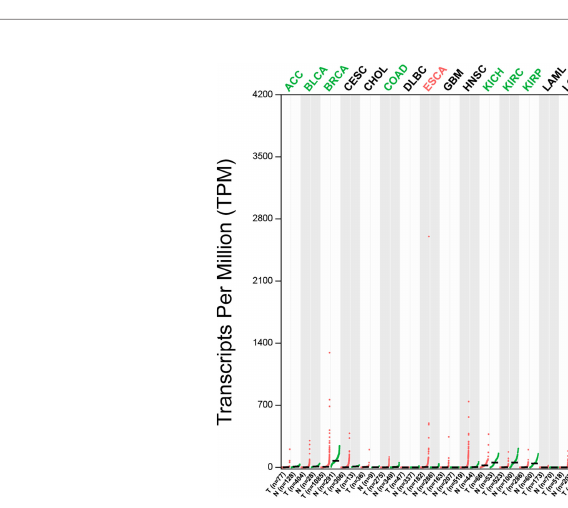
FIGURE 1 | The expression pro fi le of GPC3 across tumor samples and paired normal tissues (Dot plot). Each dot represents expression of samples. T, tumor samples; N, normal tissues; ACC, adrenocortical carcinoma; BLCA, bladder urothelial carcinoma; BRCA, breast invasive carcinoma; CESC, cervical squamous cell carcinoma & endocervical adeno; CHOL, cholangiocarcinoma; COAD, colon adenocarcinoma; DLBC, lymphoid neoplasm diffuse large B-cell lymphoma; ESCA, esophageal carcinoma, glioblastoma multiforme; HNSC, head & neck squamous cell carcinoma; KICH, kidney chromophobe cell carcinoma; KIRC, kidney renal clear cell carcinoma; KIRP, kidney renal papillary cell carcinoma; LAML, acute myeloid leukemia; LGG, brain lower grade glioma; LIHC, liver hepatocellular carcinoma; LUCD, lung adenocarcinoma; LUSC, lung squamous cell carcinoma; MESO, mesothelioma; OV, ovarian serous cystadenocarcinoma; PAAD, pancreatic adenocarcinoma; PCPG, pheochromocytoma & paraganglioma; PRAD, prostate adenocarcinoma; READ, rectum adenocarcinoma; SARC, sarcoma; SKCM, skin cutaneous melanoma; STAD, stomach adenocarcinoma; TGCT, testicular germ cell tumors; THCA, thyroid carcinoma; THYM, thymoma; UCEC, uterine corpus endometrial carcinoma; UCS, uterine carcinosarcoma; UVM, uveal